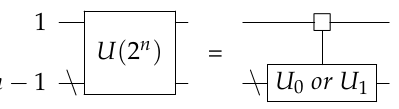
Figure 1. A quantum multiplexer.